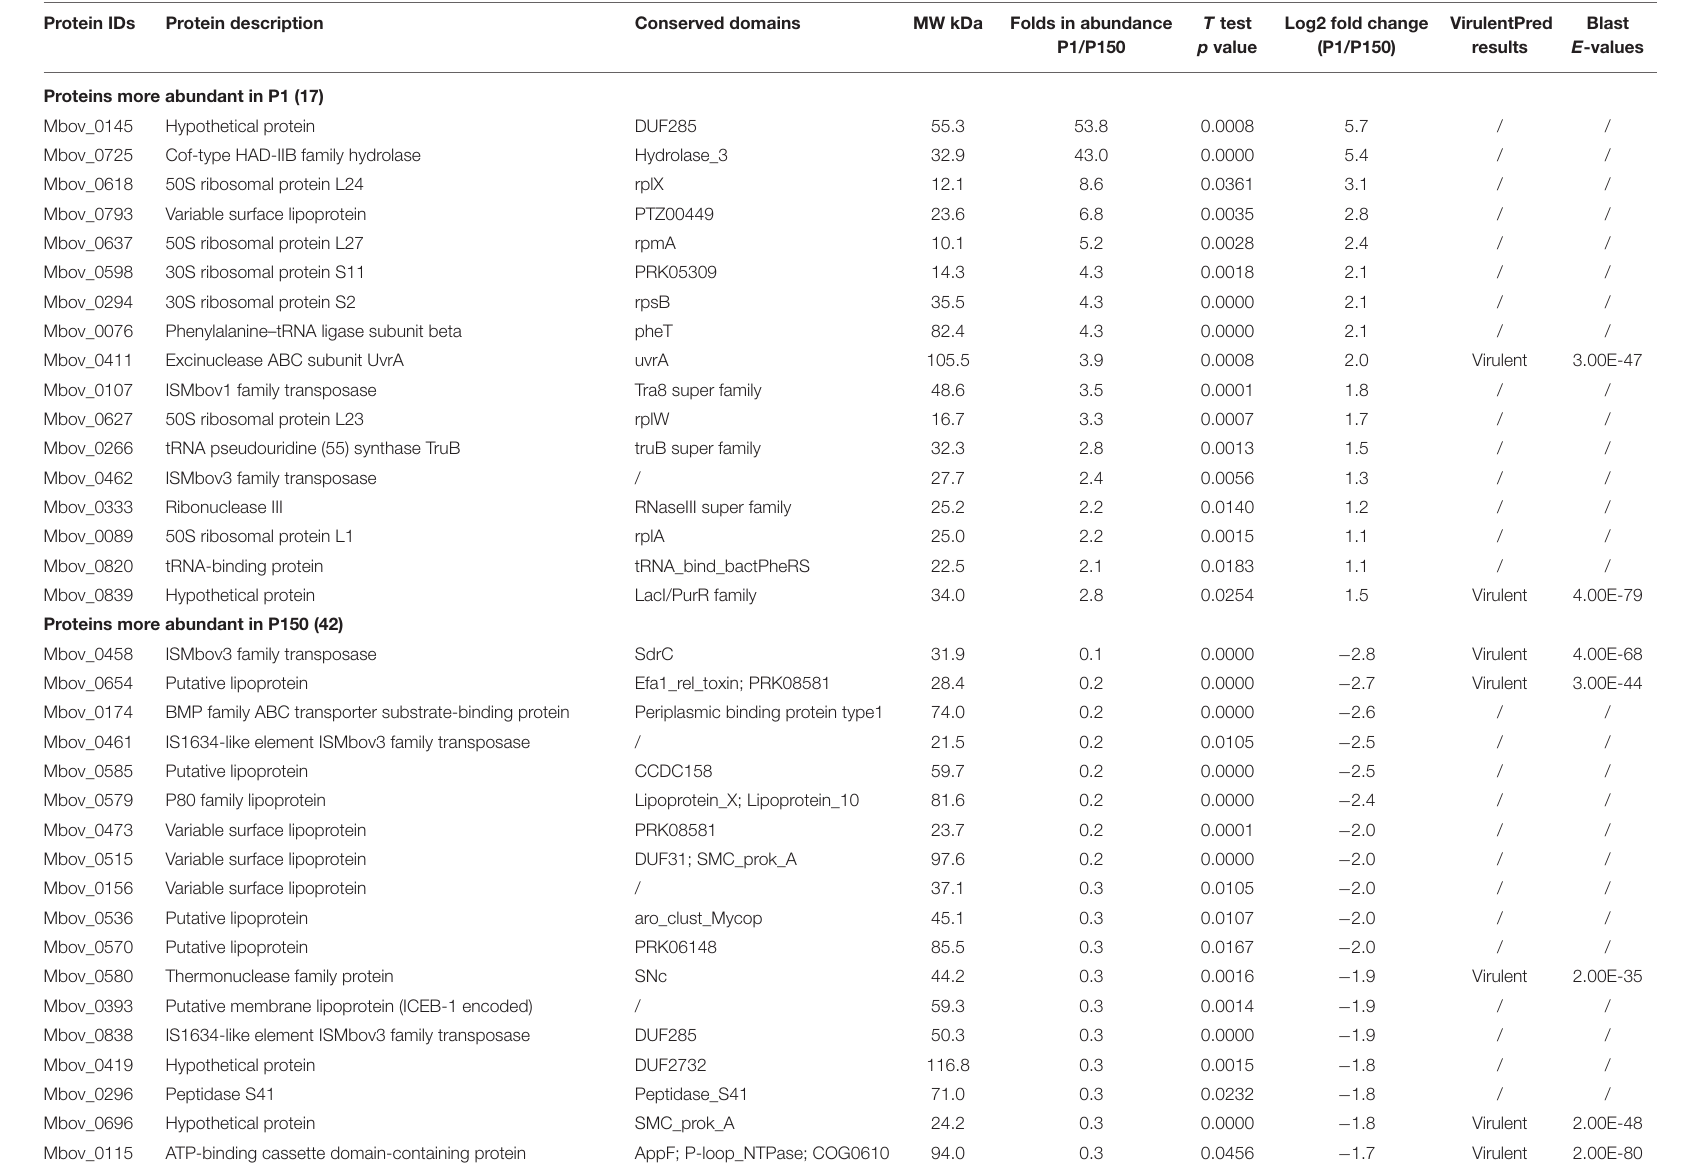
TABLE 1 | Seventy-nine differentially secreted proteins between P1 and P150 strains. Protein IDs Protein